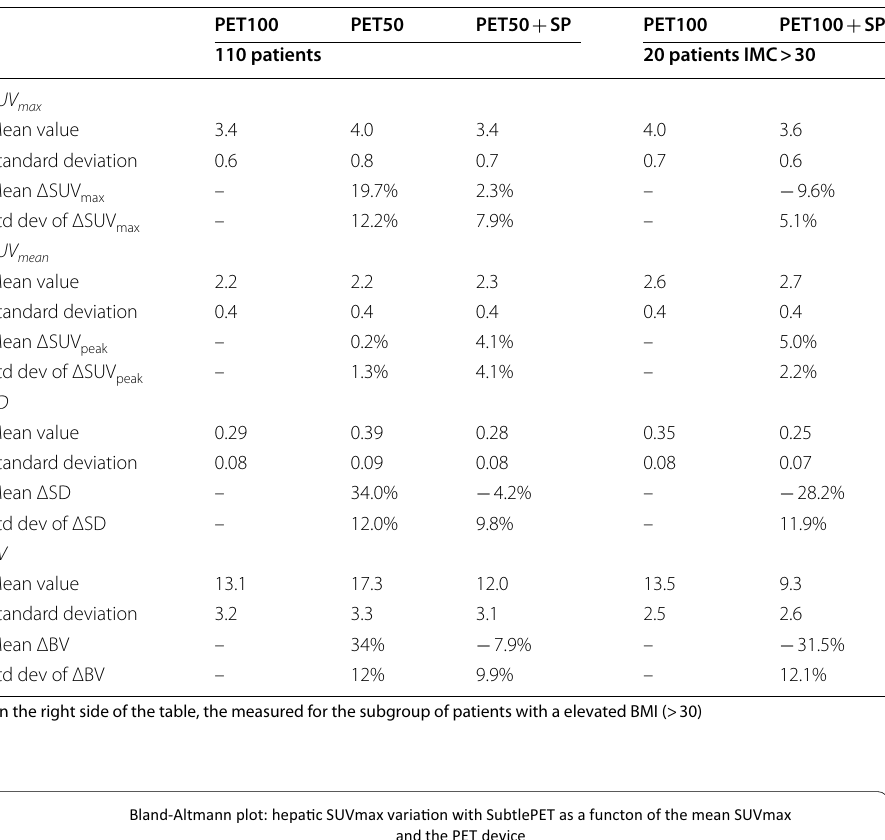
Table 7 SUV , SUV , standard deviation and background variability quantitative indexes max mean measured on the healty hepatic region on PET100, PET50 and PET50